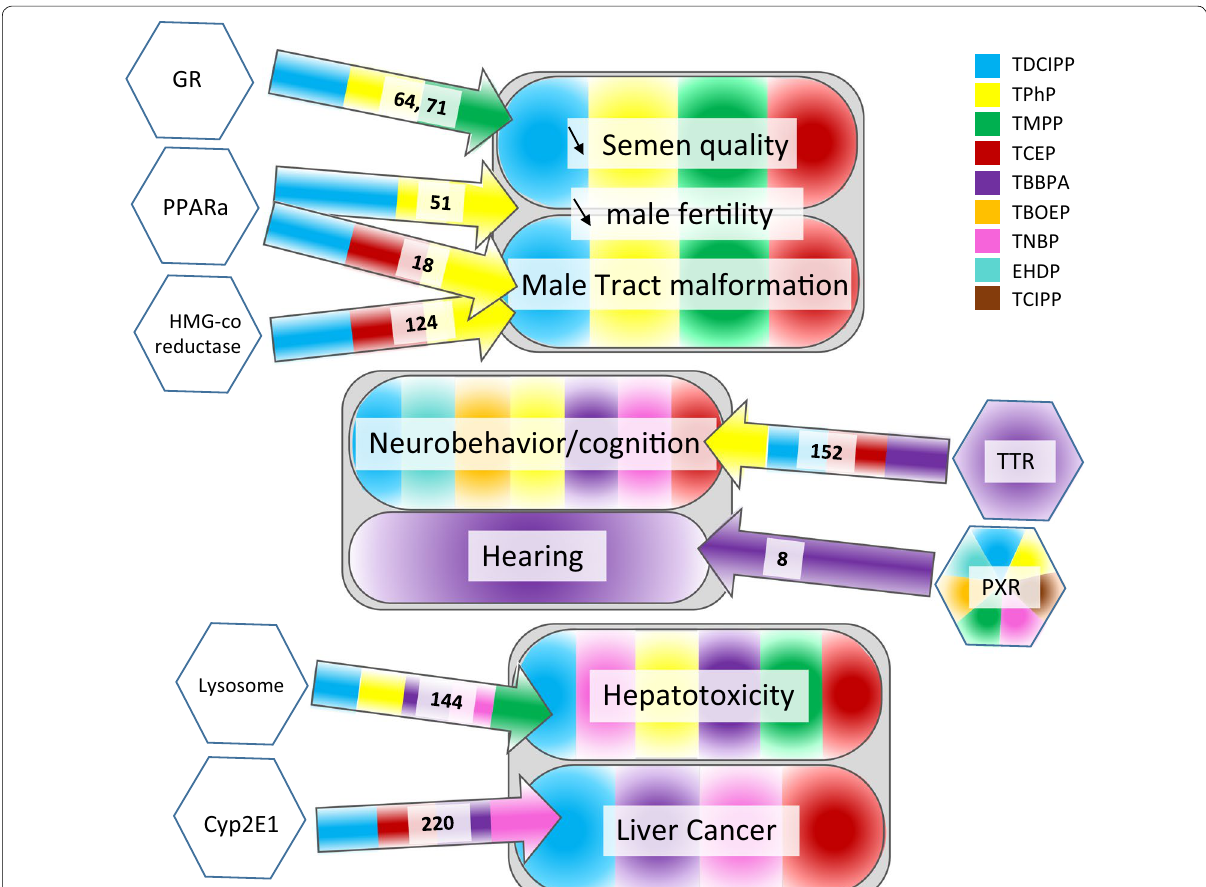
Fig. 2 Illustration of major results from literature/ToxCast/AOP search for Category I FRs. Major AOs are indicated (in ovals) with corresponding plausible AOPs (arrows with their number from the AOP-wiki) and MIE (in hexagons). A color code indicates for which Cat I FR the AOP is a plausible mechanism, or the AO or MIE has been reported. No colors at MIE indicate that the effects of FRs have not been reported so far or AC50 from ToxCast was not “verified” as explained in the text. Several other AOs, AOPs and MIEs not illustrated in this figure have been investigated and are listed in Additional file 1: Table S3. (Disclaimer: because of dynamic nature of AOP-Wiki, the information on AOPs presented in the paper reflects state of the art as of June 2018, when the information from AOP-Wiki was